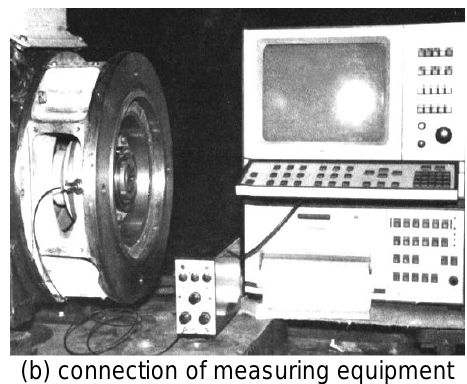
Figure 1. Outfit of vibroacoustic chamber for testing the motor EM vibration levels were measured in decibels by the mean square vibration acceleration. For the baseline vibration characteristics of AM, three-octave levels of vibration acceleration and narrow-band vibration spectra with a bandwidth of 3-10% in the range from 5 Hz to 10 kHz are